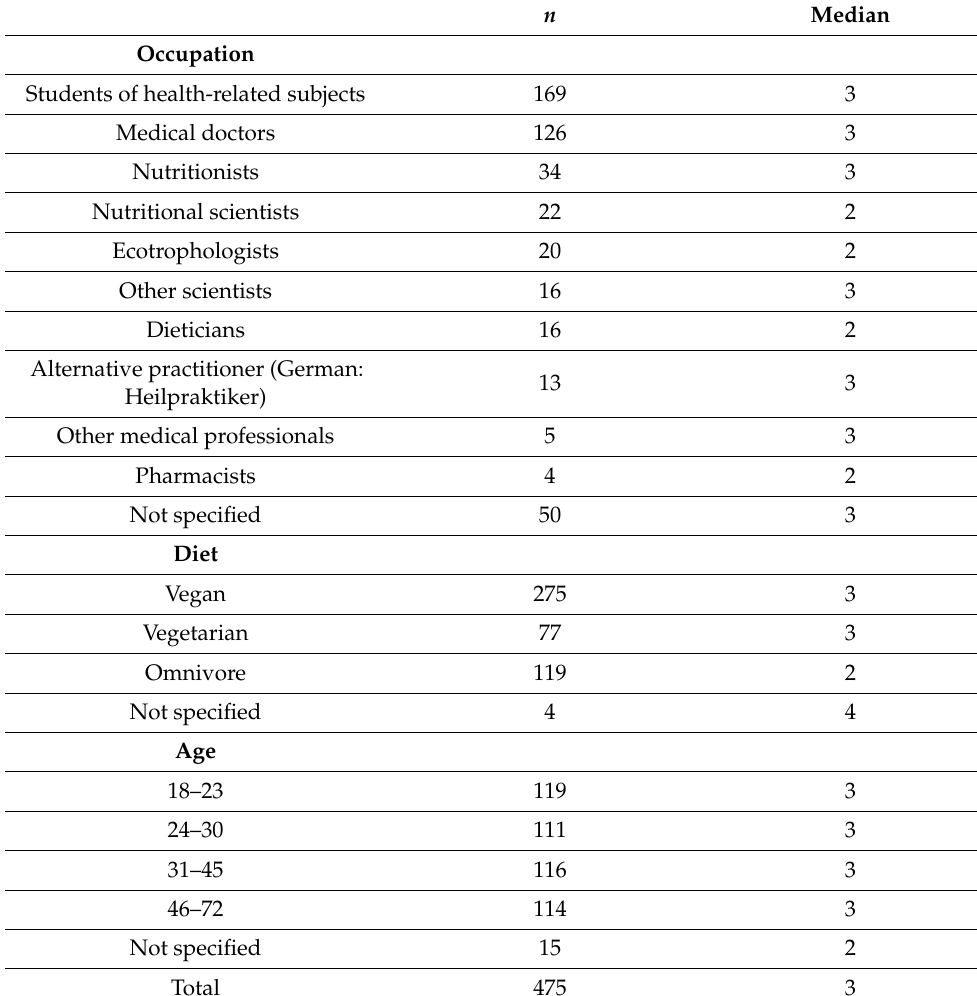
Table 4. Assessment of the competence of nutrition societies by means of school grades (1 = best to 5 =